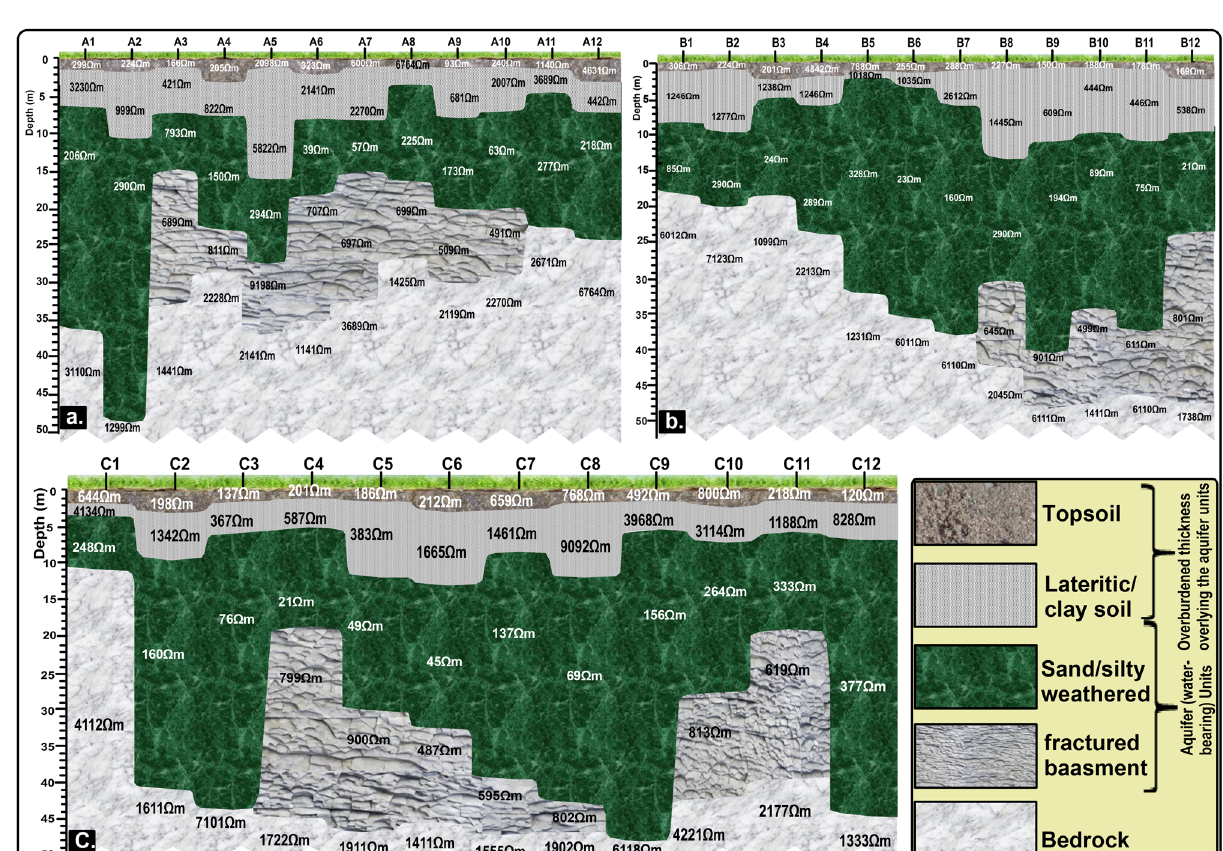
Fig. 5 Geoelectric/geologic section concerning five sounding points of the first to third profile ( a – c ) of the study area showing the resistivity values and the layer